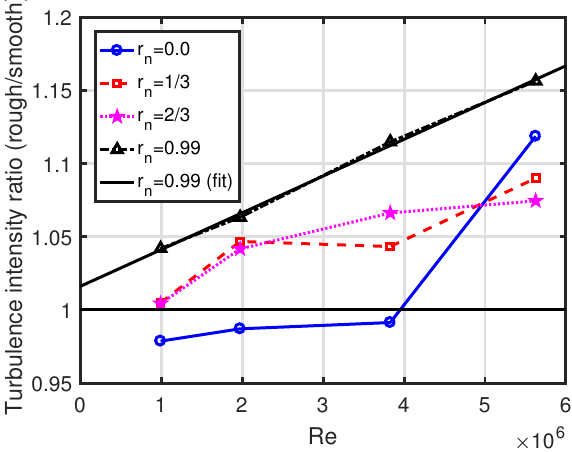
Figure 4. Turbulence intensity ratios for fixed r n .